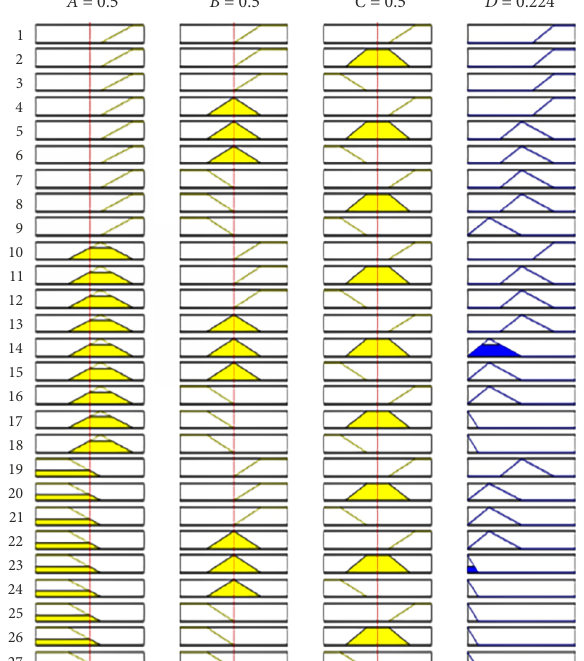
Figure 9. Fuzzy rules in fuzzy toolbox